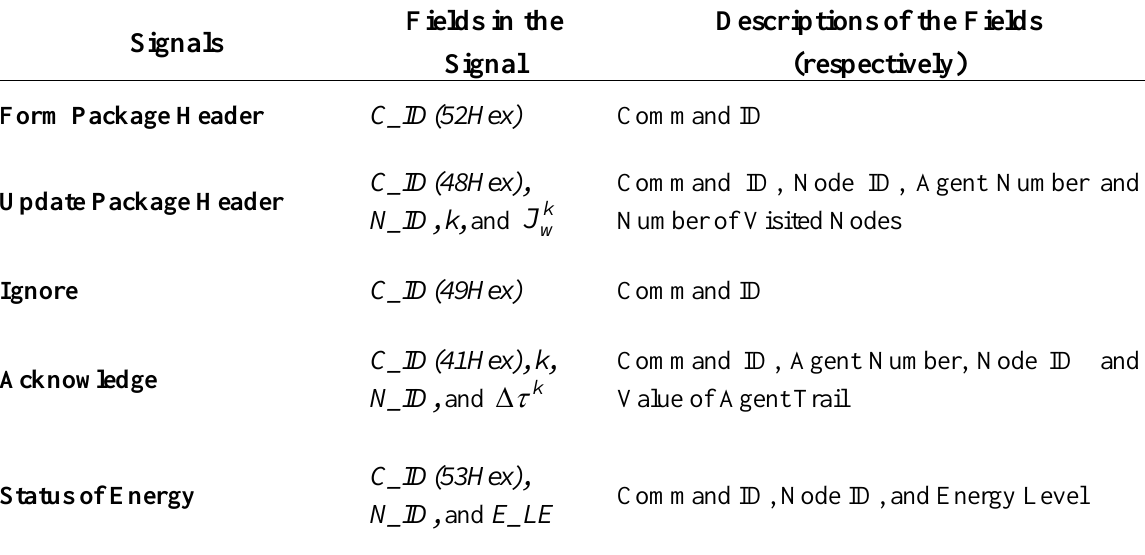
Table 4. Signals used in router chip